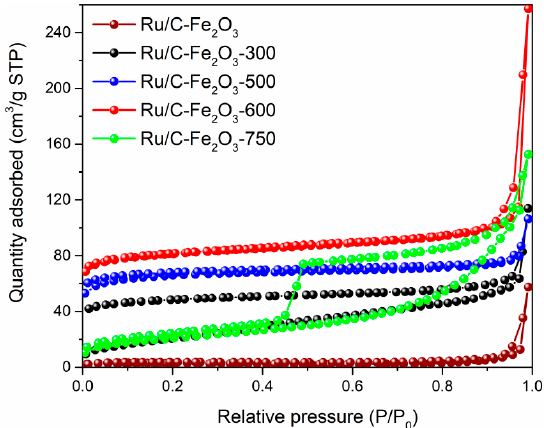
Figure 5. The typical nitrogen adsorption–desorption isotherms of all tested catalysts. Table 1. Effect of the annealing temperature on properties of catalysts.